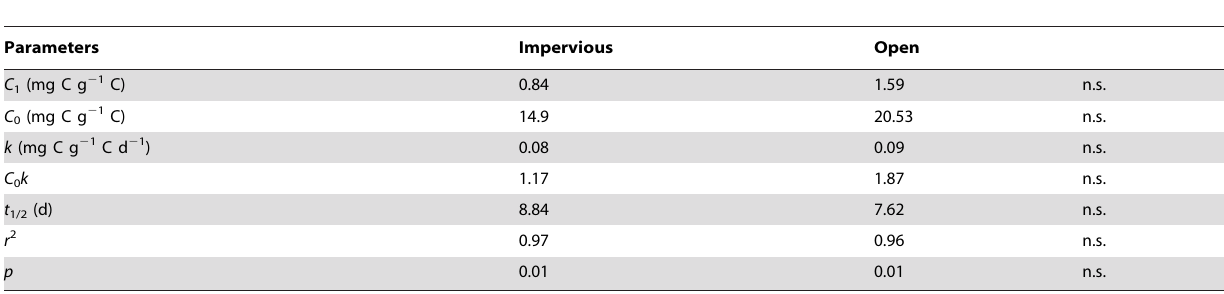
Table 4. The first-order decay model (Eq. 2) parameters and coefficients of determination ( r 2 ) for carbon mineralization in urban impervious-covered and open